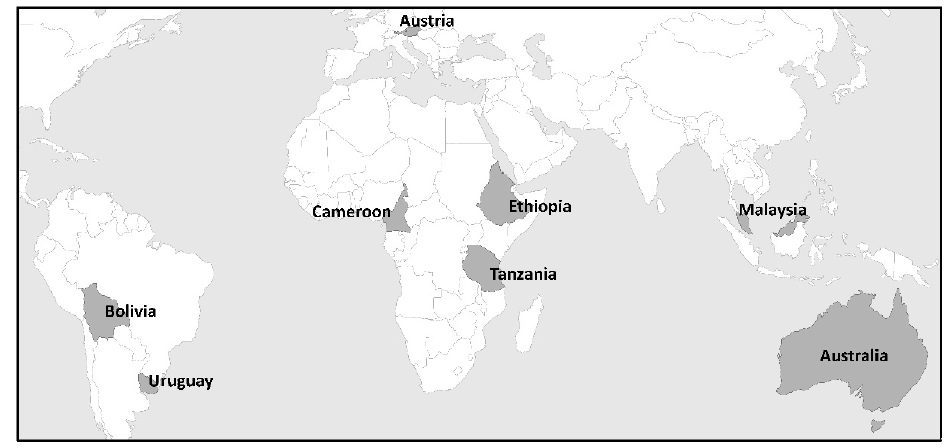
Figure 1. Study countries and regions.